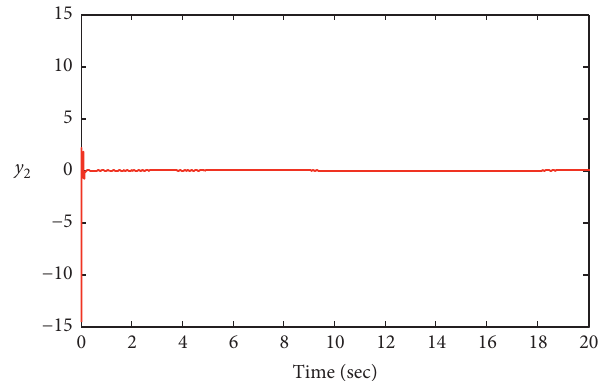
Figure 6: Profiles of the boundary layer error y